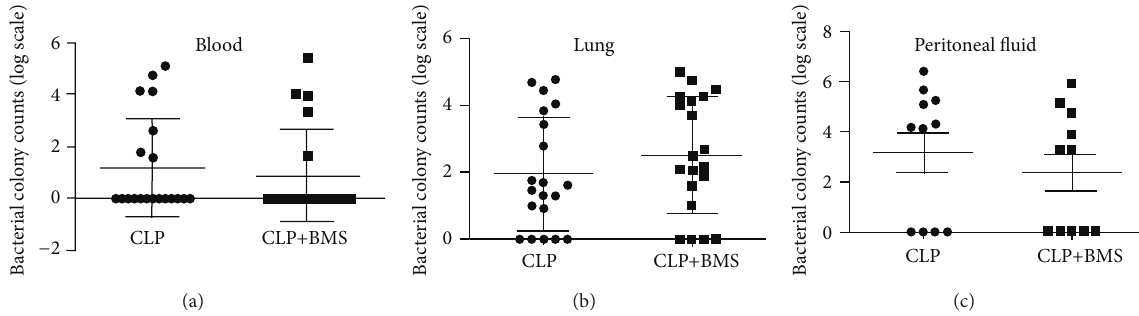
Figure 5: Inhibition of NF- 𝜅 B does not affect bacterial clearance after CLP. Bacterial colony counts in mice subjected to CLP+BMS and CLP+vehicle were assessed on samples from (a) blood ( 𝑁 = 20 per group), (b) lung tissue ( 𝑁 = 20 per group), and (c) peritoneal fluid ( 𝑁 = 11 per group) obtained at 24 hours after CLP. 𝑋 -axis represents different groups and 𝑦 -axis represents log scale for bacterial colony counts isolated from different sites. Results were represented as mean ± SE.